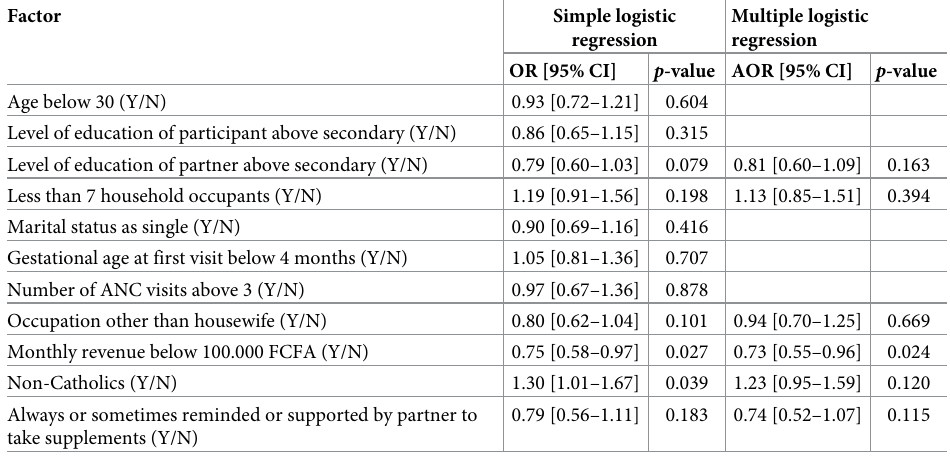
Table 3. Sociodemographic and obstetric factors associated with total crude hypocalcaemia.